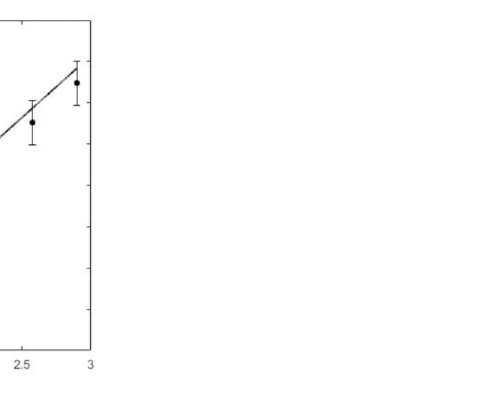
Fig 8. Results from Experiment 2 with best-fitting piecewise linear regression. The dashed line shows the linear fit up to the transition point and the solid line shows the linear fit past the transition point. Error bars indicate ± one standard error of the